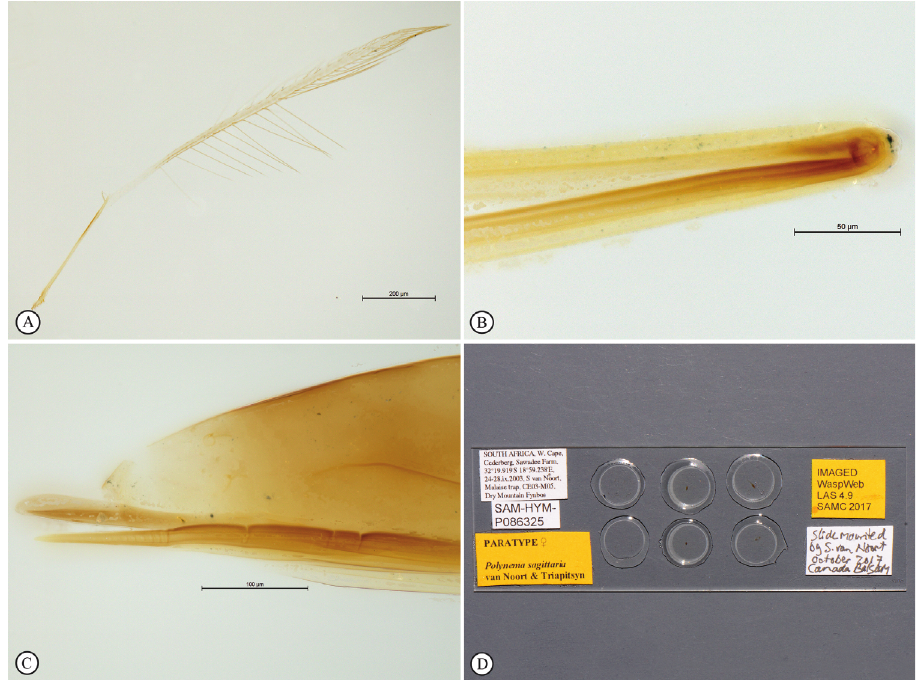
Figure 4. Polynema sagittaria Paratype female, slide-mounted. A Hind wing, dorsal view B Ovipositor distal flexion, lateral view C Ovipositor valves with terminal annuli and three dorsal notches on dorsal valve, sheaths and terminal metasomal segments, lateral view D Slide